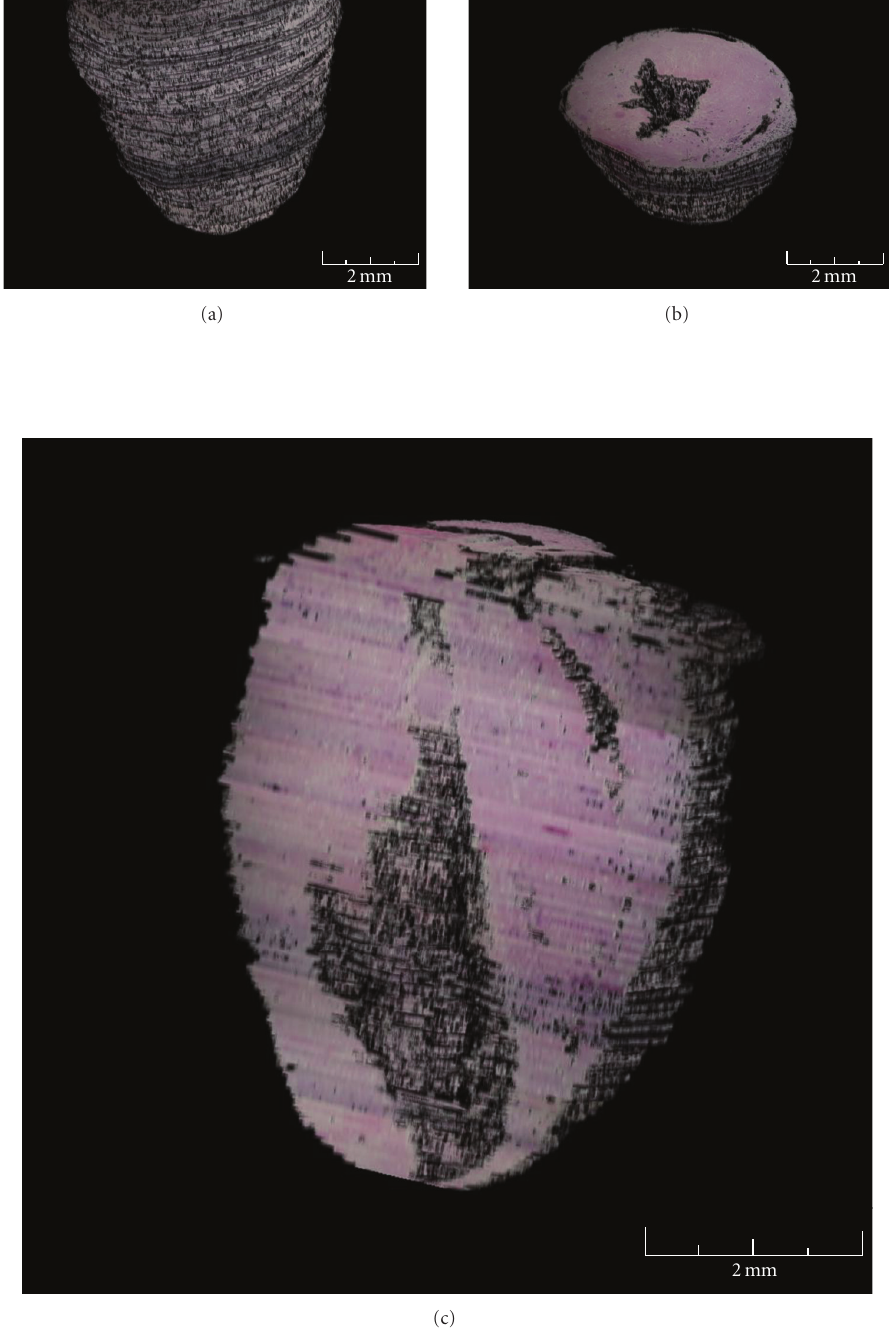
Figure 8: 3D views of the heart model. (a) Isometric view of the whole heart model. (b) Isometric view of the horizontal section of the heart model. (c) Isometric view of the vertical section of the heart model. In this image, we can see the ventricles of the mouse heart and the thickness of the heart